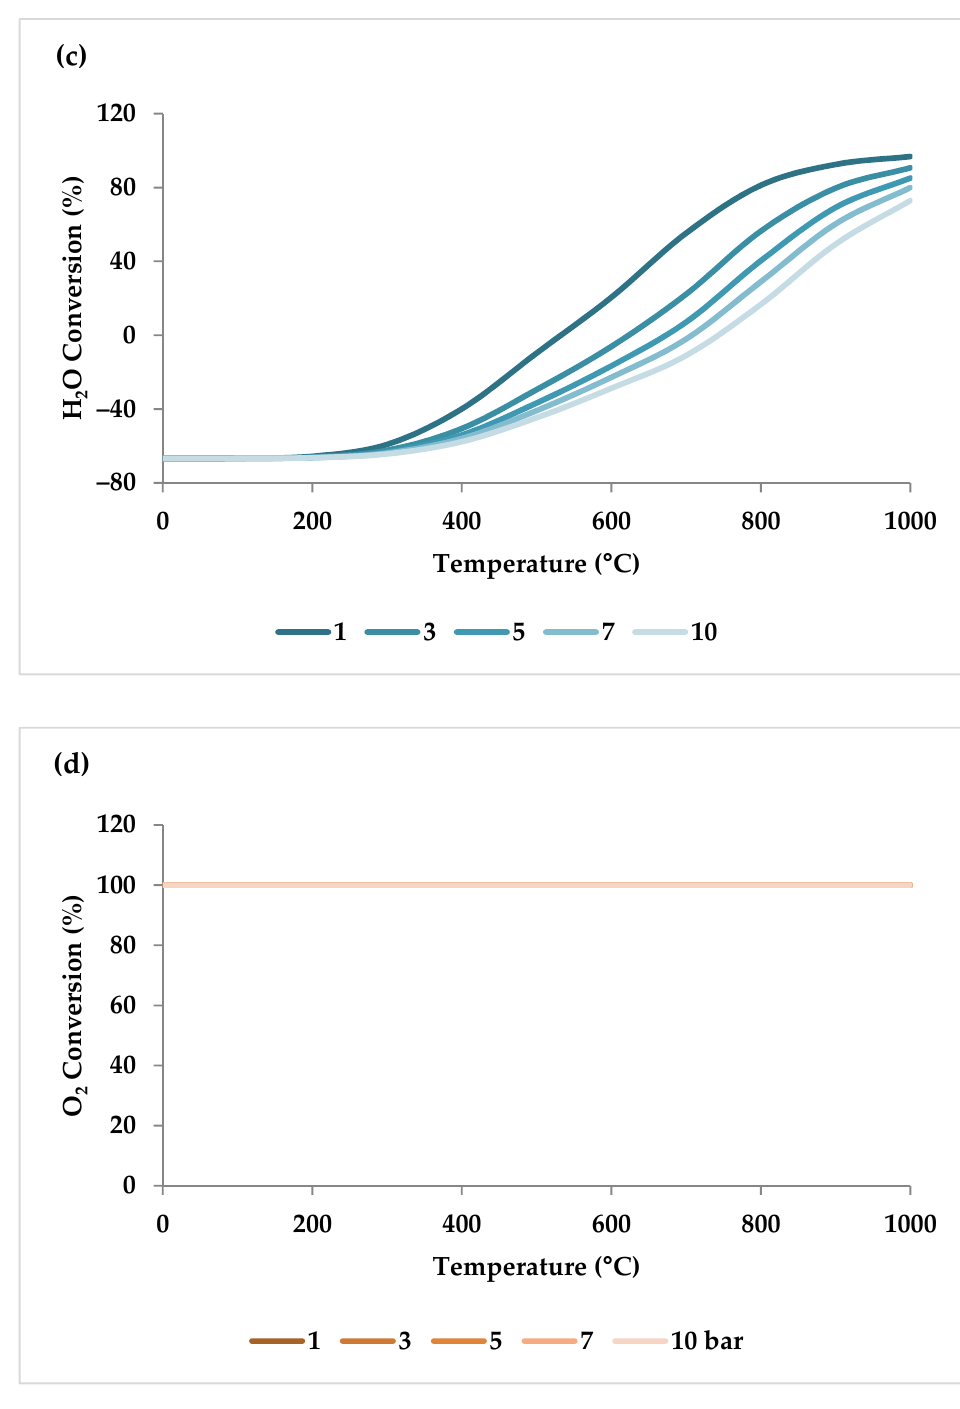
Figure 8. ( a – d ) Thermodynamic equilibrium conversions of feed gases under different pressures (bar) versus temperature, molar ratio: CH 4 :CO 2 :H 2 O:O 2 = 1:0.3:0.3:0.2. Table 2. Simulation settings and conditions considered for Figures 7 and 8.